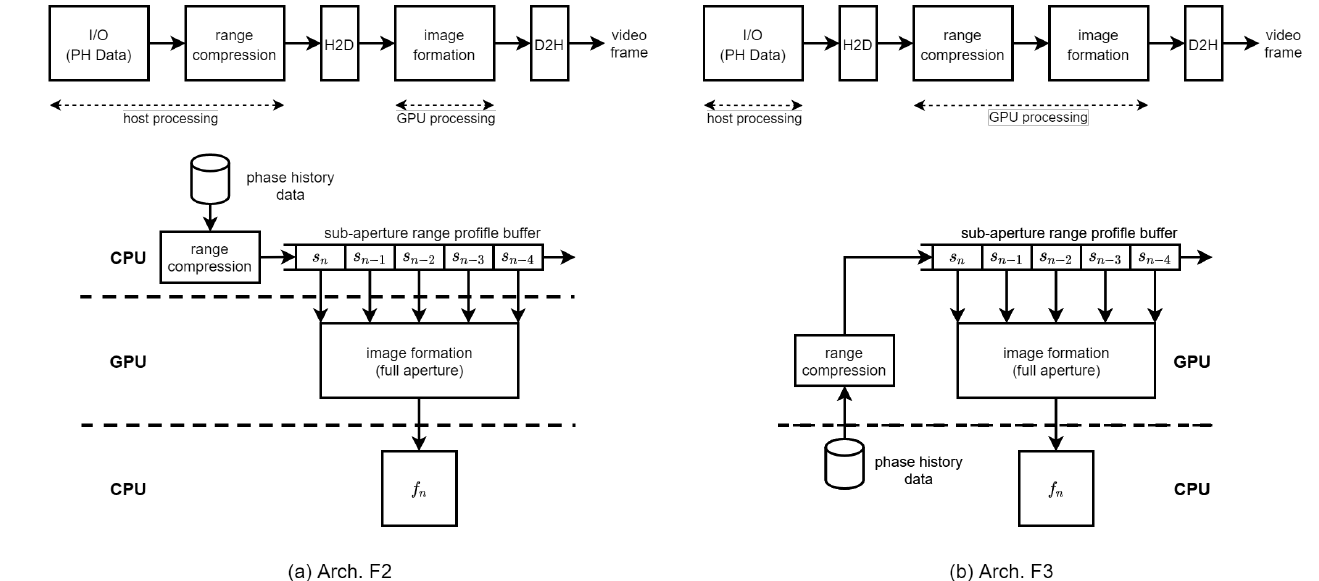
Figure 4. BP-VISAR: full-aperture processing